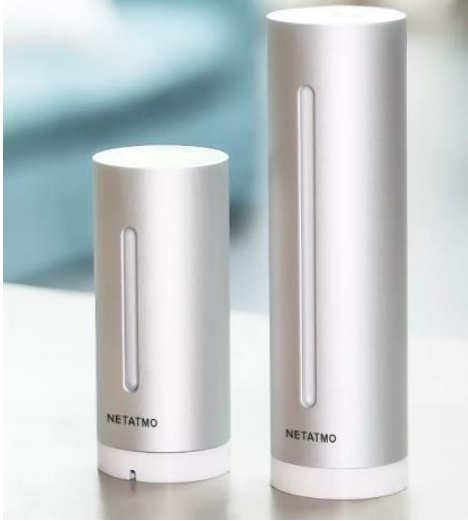
Figure 2. Netatmo weather station outdoor unit ( left ) and indoor unit ( right ). (Photo by Netatmo, reproduced with permission).